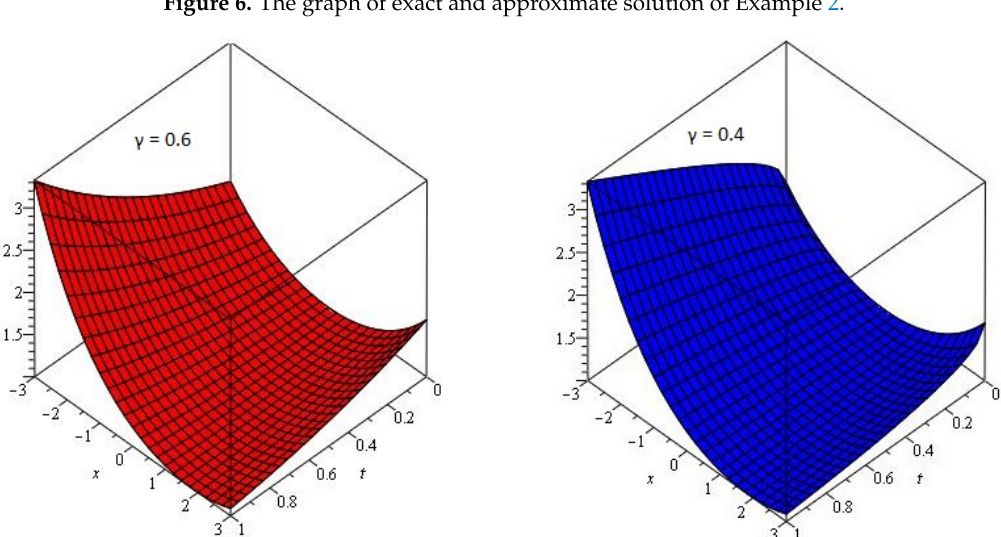
Figure 7. The NDM solutions of different valve of γ of Example 2.